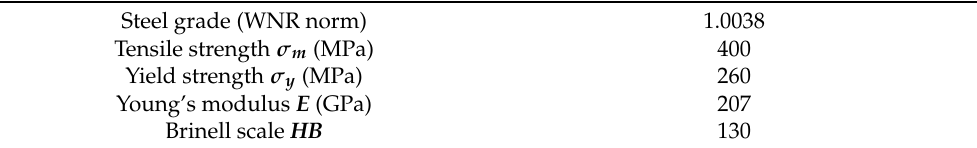
Table 2. Mechanical properties of the used steels.